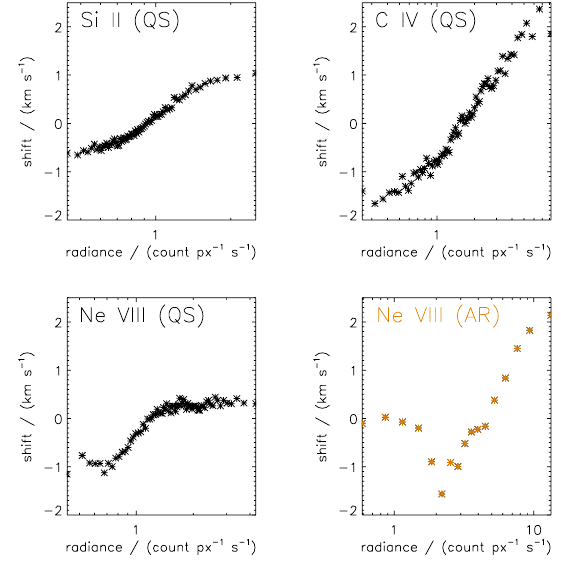
Fig. 7. The interrelation between brightness and Doppler shift is clearly seen in TR emission of the quiet Sun: Si II 1533, C IV 1548, and Ne VIII 770. For comparison we also show a similar plot in Ne VIII for an AR (upper left to lower